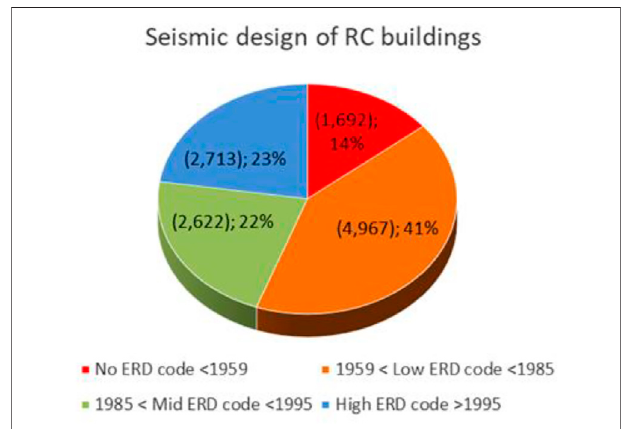
FIGURE 11 | Age distribution of RC buildings in Samos in relation to the design code (ERD stands for Earthquake Resistant Design).